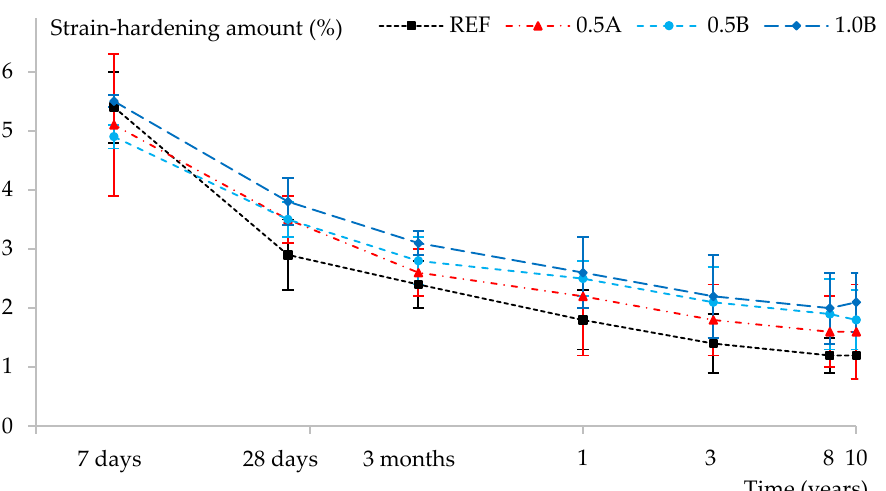
Figure 2. The amount of ductility as measured by the amount of flexural strain-hardening in the stress-strain curve (%) as a function of the time.